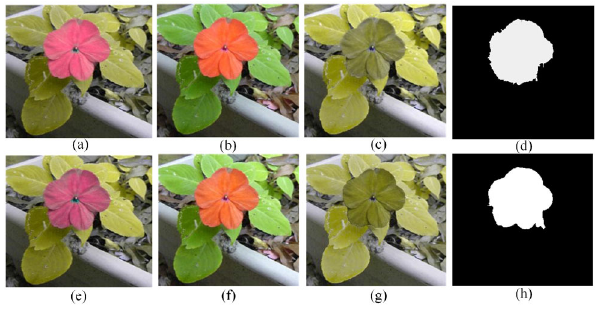
Fig. 6 Colorblind image correction. (a) Effect of enhancing green blindness; (e) effect of enhancing red blindness; (b, f): (a, e) converted to standard color images, respectively; (c, g) colorblind simulated images of (b, f), respectively; (d, h) saliency maps of (c, g),